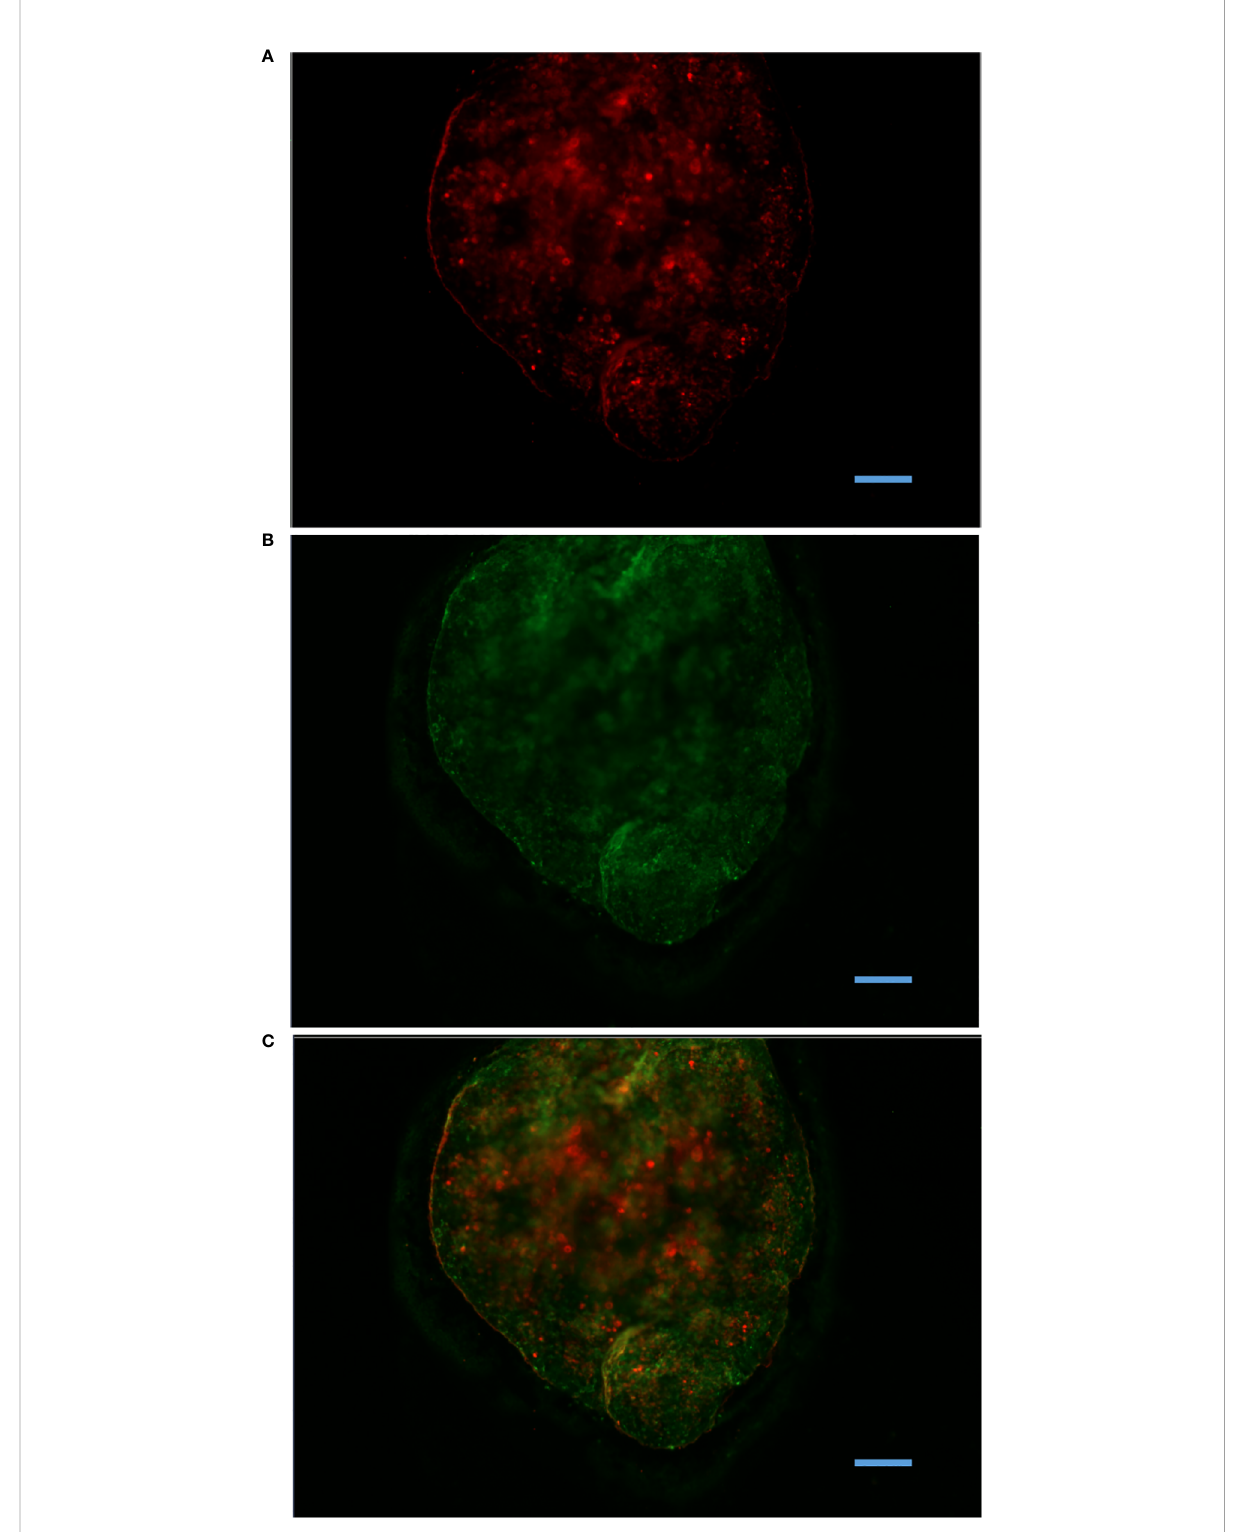
FIGURE 4 Antigen retention within MM F C isolated from zebra fi sh spleen. Spleen MM F C isolated from zebra fi sh immunized with BSA-Alexa647, one month following the vaccination. (A) BSA-Alexa-647 is visible in the Cy5 channel. (B) Auto- fl uorescent MM F s are visible in the FITC channel. (C) Merge. Alexa647 was only observed in clusters, and not in surrounding